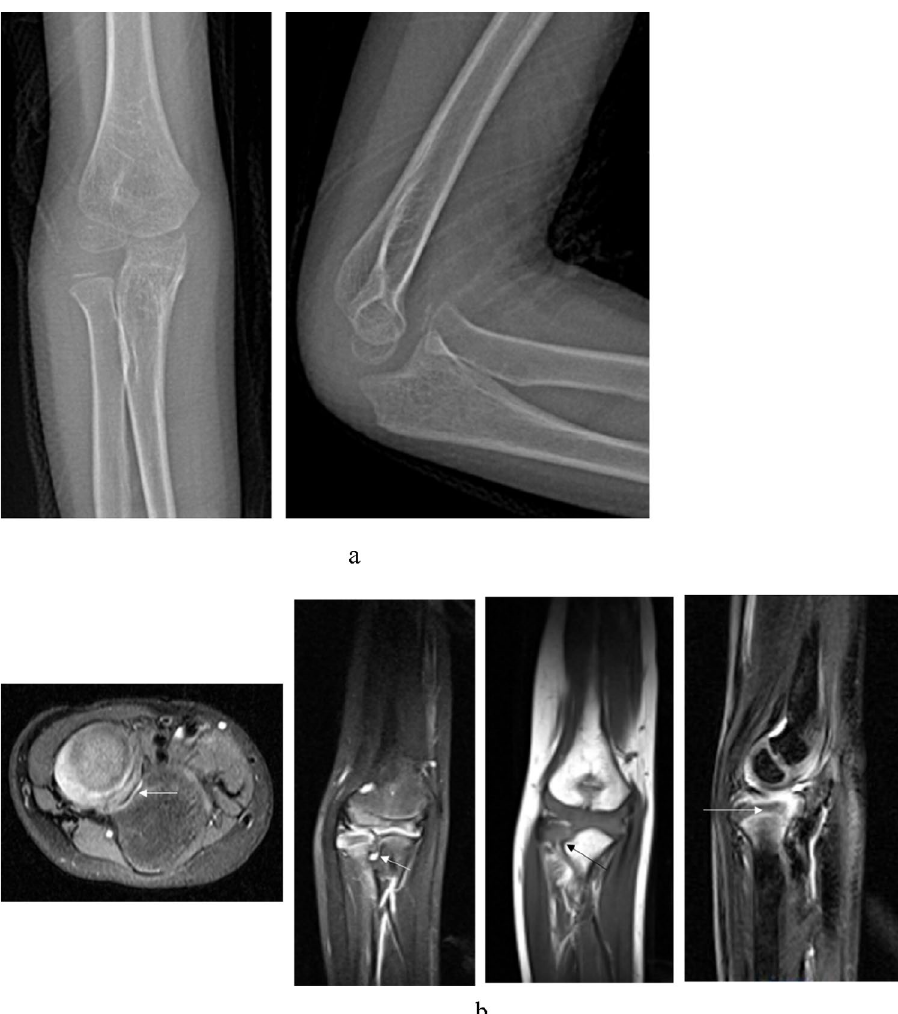
Figure 2. Imaging of a 7 years old boy (case 2) referred for the treatment of missed Monteggia lesion. His internal time between injury and operation was 8 months. ( a ) Preoperative X-ray. ( b ) Preoperative MRI. Axial T2-weighted images demonstrated the proximal radioulnar joint was dislocated and the appearance of the radial notch (the arrow) was flat; coronal T1- and T2-weighted images showed the radial notch of the ulna was hyperplasia (the arrow); sagittal T1-weighted images showed the dislocation of the humeroradial joint and the concave radial head (the arrow) combined with the folded and tortuousness annual ligament in the joint. ( c ) Open reduction and ulnar osteotomy with reconstruction of the annular ligament and a humeroradial pin was undertaken. ( d ) The radial head subluxated (Grade 3) at 2 years after